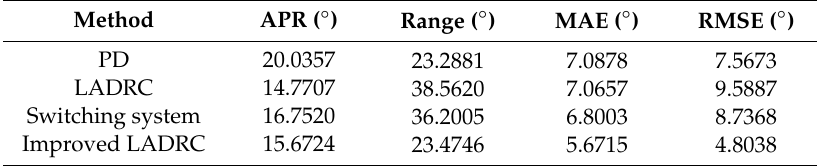
Table 2. Stabilization precision of visual sensor platform with di ff erent